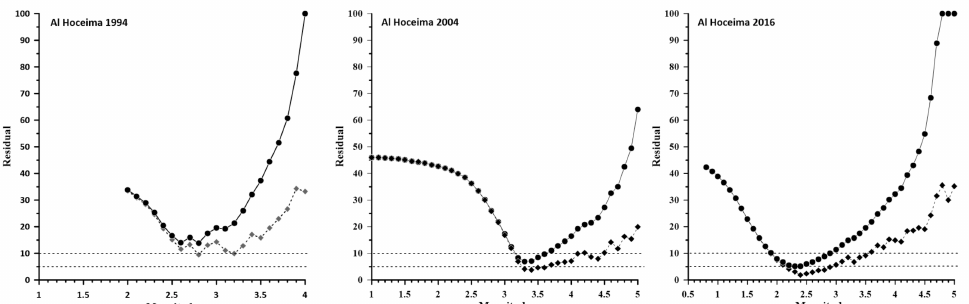
Figure 13. The obtained residuals vs. magnitude when fitting the observed data to the mGft power law (solid line) and theoretical distribution power law (dashed line). The 5% and 10% residual levels are shown as